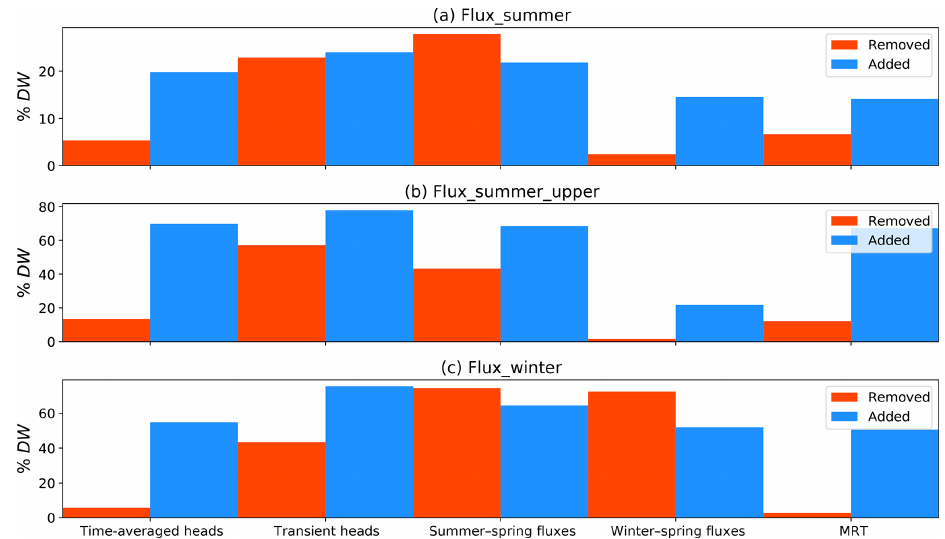
Figure 2. Worth of different observation groups (%DW) with respect to forecasts: (a) spring discharge flux during summer in the central Heretaunga Plains, (b) spring discharge flux during summer in the upper portion of the Heretaunga Plains and (c) spring discharge flux during winter in the central Heretaunga Plains (see Fig. 1 for locations). The %DW value is quantified as both the increase in forecast uncertainty variance following the removal of an observation group available for conditioning (red) and the decrease in forecast uncertainty variance following the addition of an observation group available for conditioning (blue) (see Appendix A). Note the different scales on the y